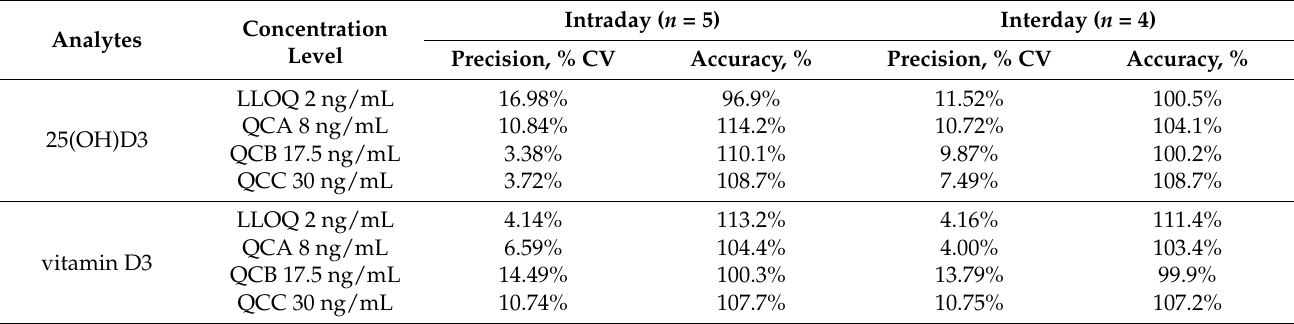
Table 1. Method validation results for intraday/interday precision, accuracy, and recovery in human serum